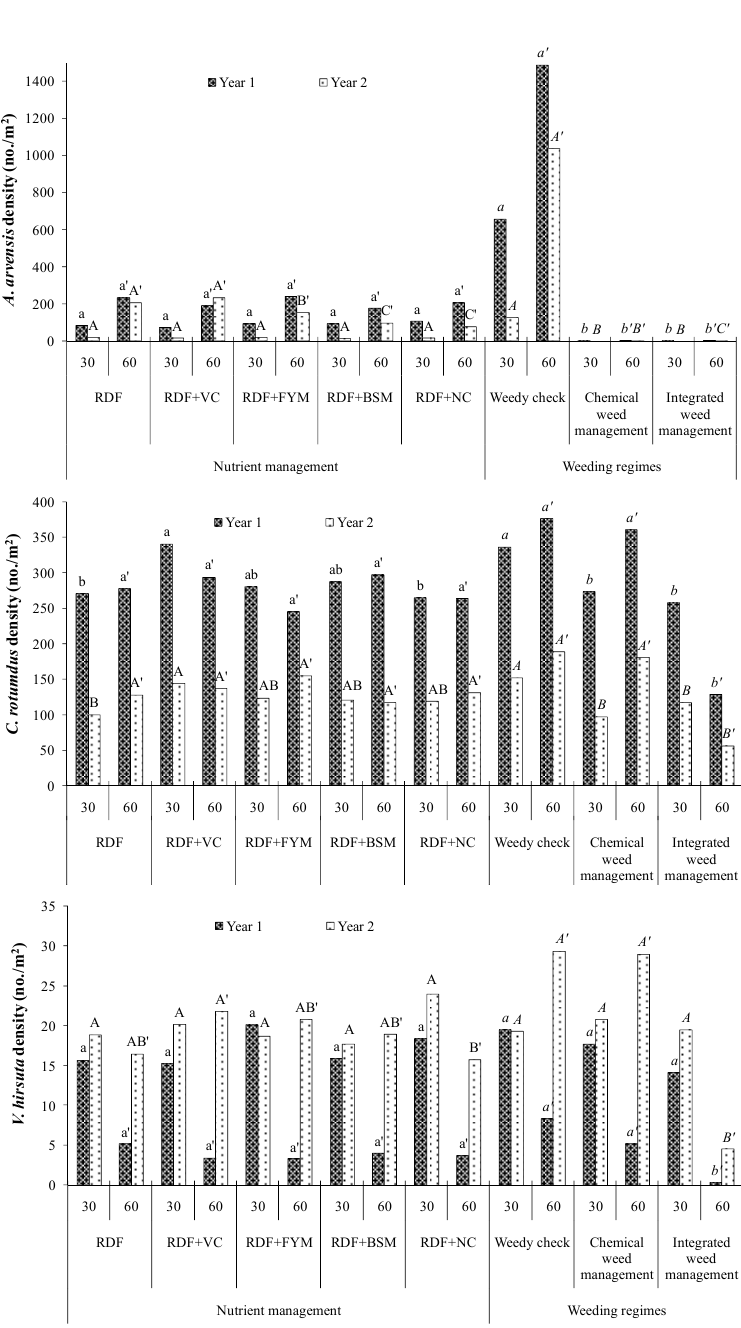
Figure 1. Effect of different nutrient managements and weeding regimes on weed density at 30 and 60 days after seeding (DAS) in hybrid maize. RDF (recommended dose of fertilizer): 100% recommended dose (RD) of NPK through fertilizer, RDF + VC: 25% RDN through VC, RDF + FYM: 25% RDN through FYM, RDF + BSM: 25% RDN through BSM, RDF + NC: 25% RDN through NC, Weedy check: Un-weeded control, Chemical weed management: Atrazine 1000 g/ha at 2 DAS, Integrated weed management: Atrazine 1000 g ha -1 at 2 DAS followed by mechanical weeding at 30 DAS . Effects of nutrient source recorded at 30 DAS in year 1 indicated with the lower case of letter (a, b or ab) and indicated with upper case of letter (A, B or AB) in year 2; however data recorded at 60 DAS indicate as lower case with ( ′ ) (a’ or b’) in year 1 and upper case with ( ′ ) (A’, B’ or AB’) in year 2; while effect of weed management in year 1 as italic lower case (a, b or ab), in year 2, italic upper case (A, B or AB) at 30 DAS, as italic lower case with ( ′ ) (a’ or b’) in year 1 and italic upper case with ( ′ ) (A’, B’ or AB’) in year 2 at 60 DAS.